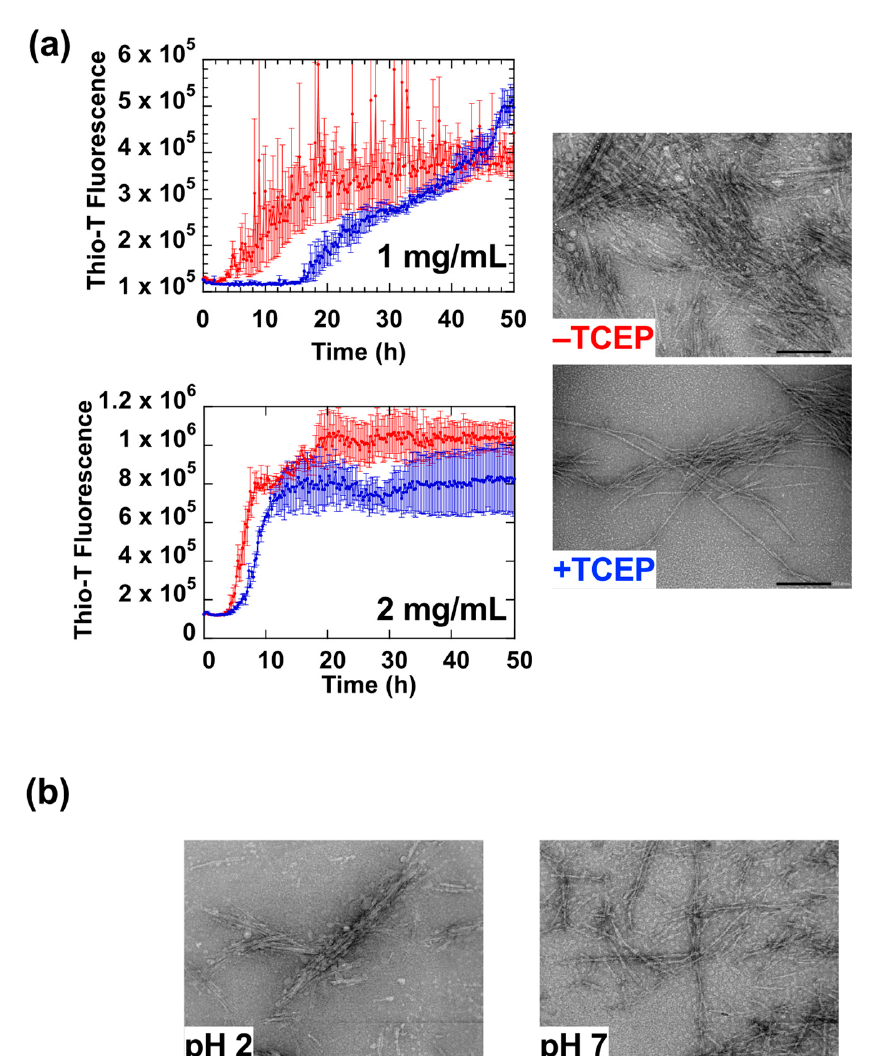
Figure 5. Fibril formation of reduced HdeB at pH 2. ( a ) Fibrillation at different concentrations of HdeB demonstrate the concentration dependence of the initial nucleus-forming lag phase. The upper panel shows assays performed at a protein concentration of 1 mg/mL, and the lower panel shows experiments performed at a protein concentration of 2 mg/mL. Red traces in each panel denote experiments with disulfide-intact HdeB, and blue traces denote experiments with 0.5 mM TCEP added to reduce the Cys10-Cys58 disulfide bond. Note the shortened lag phase in the blue traces at higher HdeB concentrations. To the right of the traces are representative TEM images of HdeB fibrils formed in the absence and presence of TCEP. Aliquots were taken from experiments shown in the upper panel (performed at 1 mg/mL). Images were taken at a magnification of ×50,000; scale bars denote 200 nm. ( b ) Fibrils of reduced HdeB formed at pH 2 are resistant to resolubilization at pH 7.